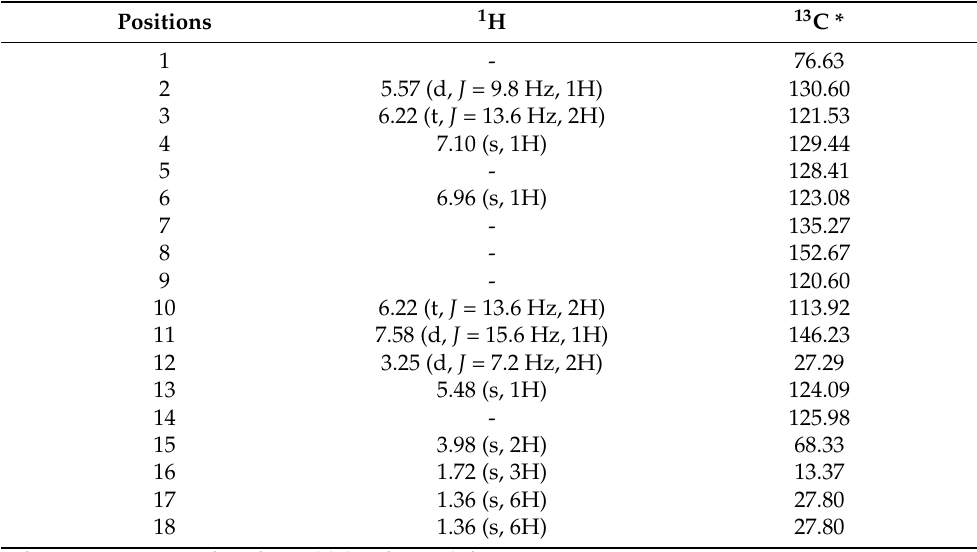
Table 2. NMR Data for 1 ’ ( 500 MHz for 1 H and 125 MHz for 13 C, in CDCl 3 , δ in ppm, J in Hz).